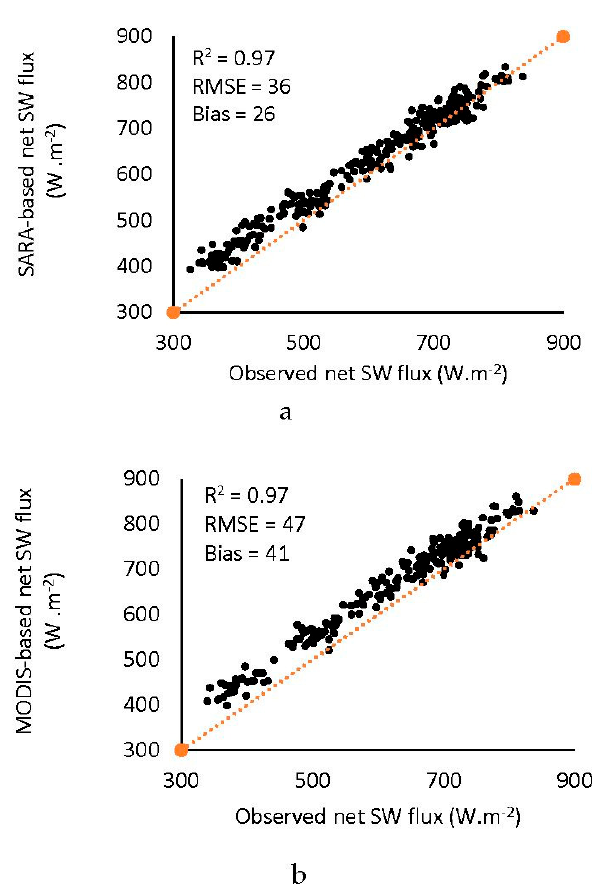
Figure 5. Scatterplots showing the relationships between each of SARA-based ( a ) and MODIS-based ( b ) net SW radiative fluxes and observed fluxes at the SGP sites in 2014.